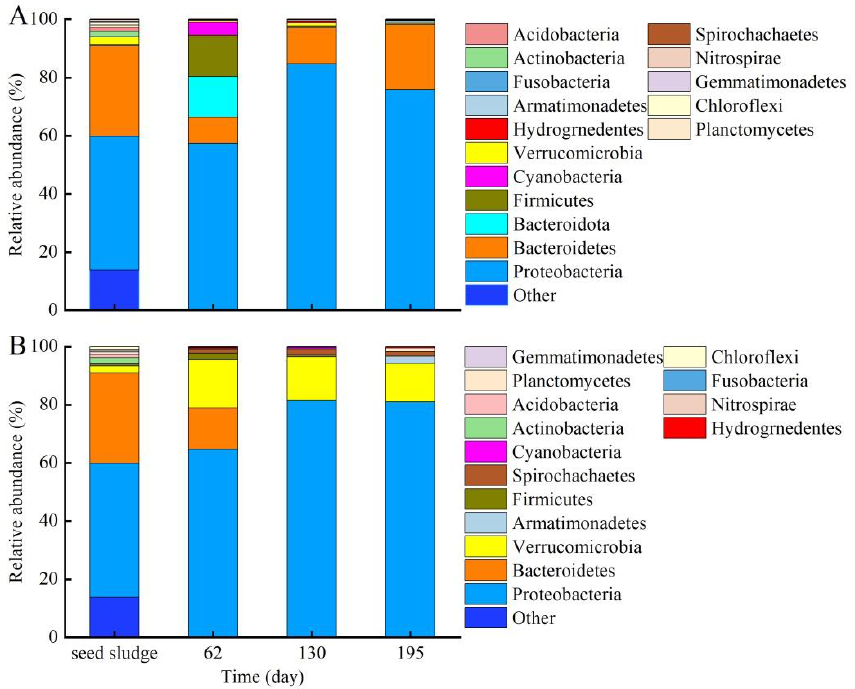
Figure 9. Microbial community structure and distribution at phylum level in R1 and R2 during the long-term operation period. ( A ) for R1; ( B ) for R2